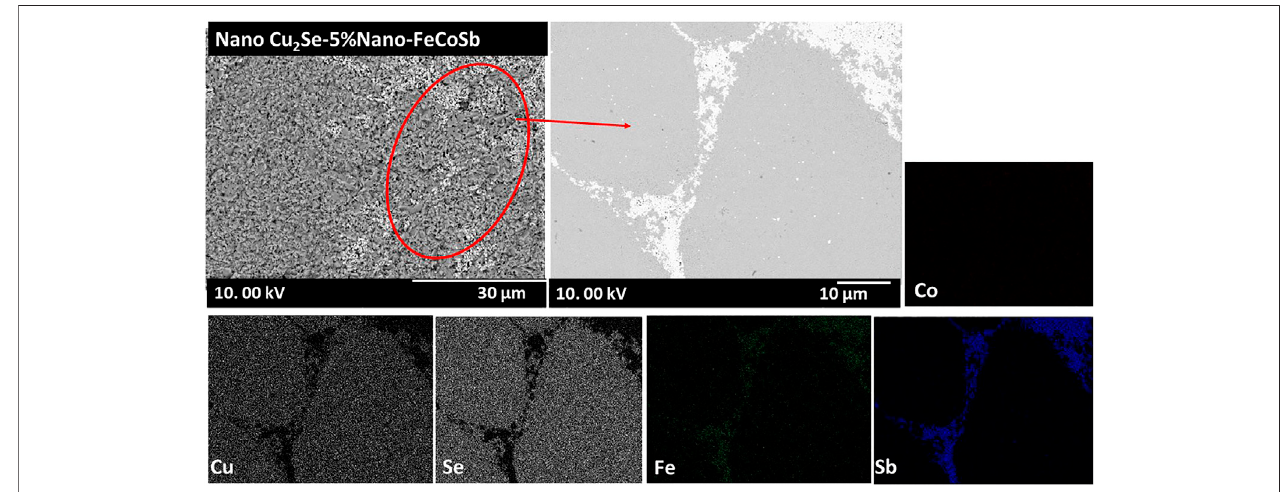
Figure 3 con fi rms the phase purity of Cu distribution of Cu and Se elements in the structure. Figure 4